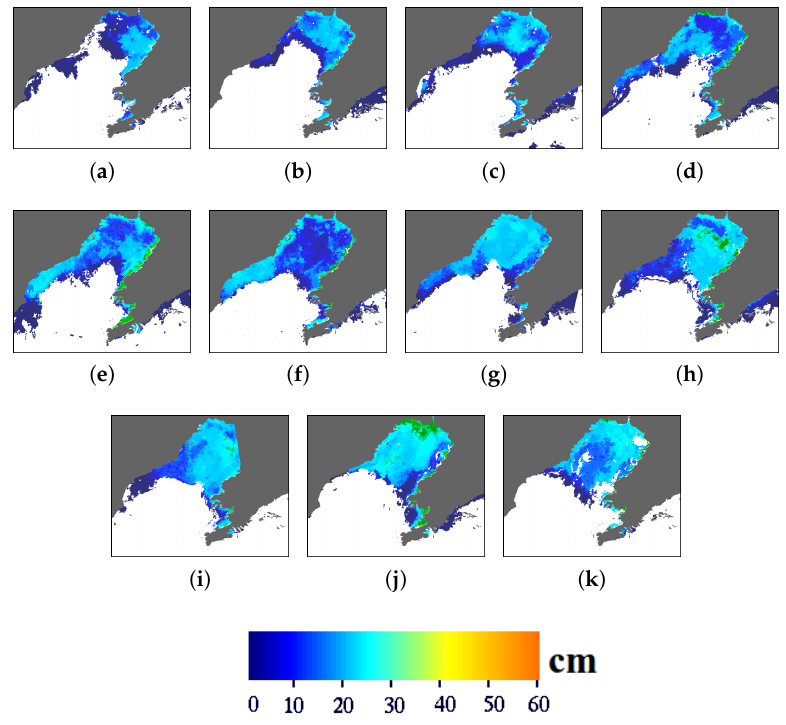
Figure 19. Sea ice thickness estimation using the RADARSAT-2 SAR imagery: ( a ) 2 january 2013; ( b ) 6 January 2013; ( c ) 9 January 2013; ( d ) 16 January 2013; ( e ) 23 January 2013; ( f ) 26 January 2013; ( g ) 2 February 2013; ( h ) 9 February 2013; ( i ) 12 February 2013; ( j ) 16 February 2013; ( k ) 19 February